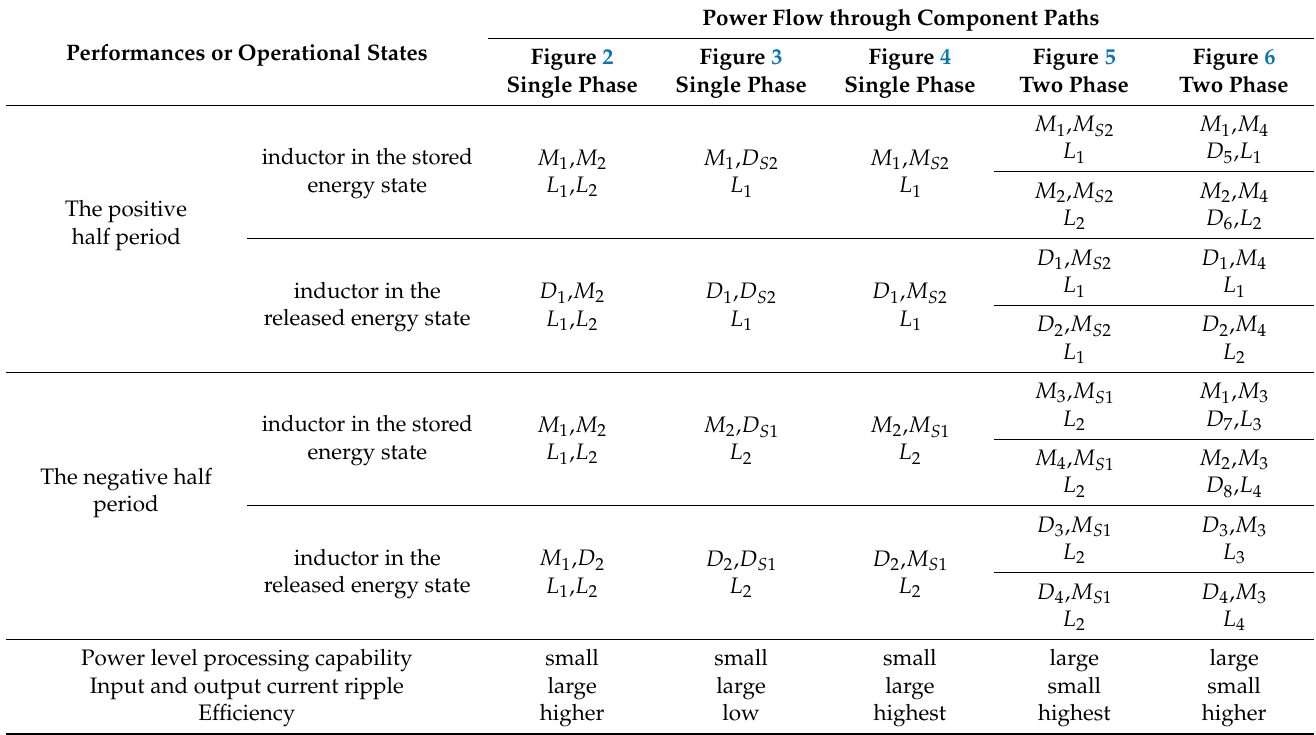
Figure 4 Single Phase